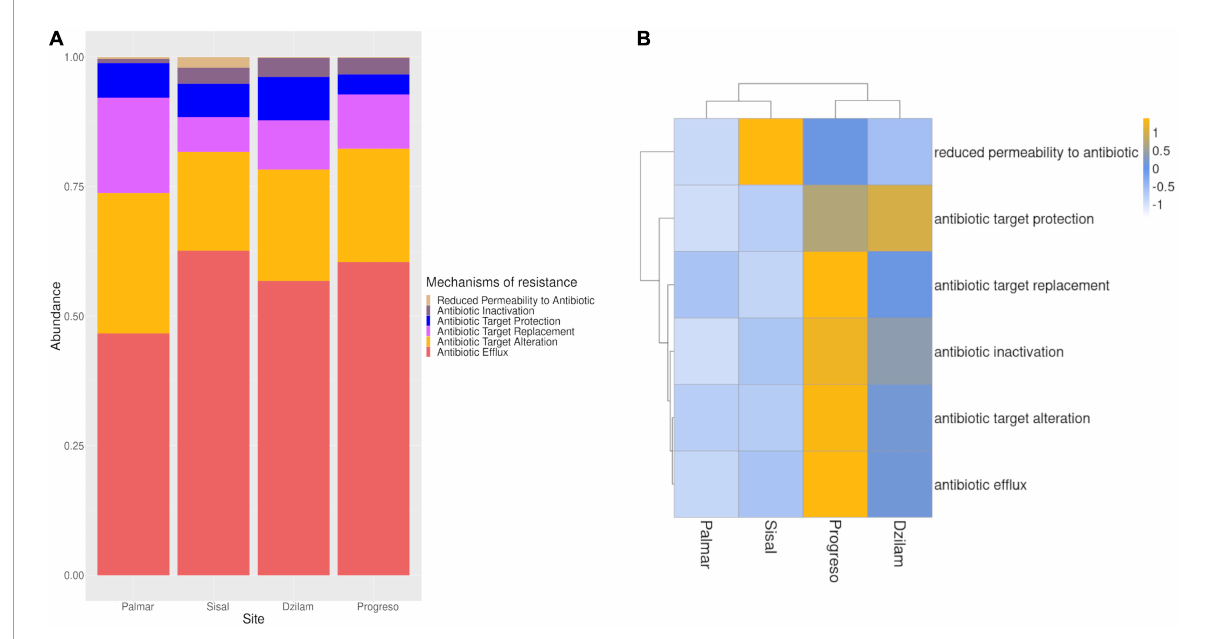
FIGURE3 Mechanisms of resistance to antibiotics found on the Yucatan coast. (A) Relative abundance of mechanisms of antibiotic resistance. (B) Heatmap representing the number of mechanisms of resistance to antibiotics found in each site.